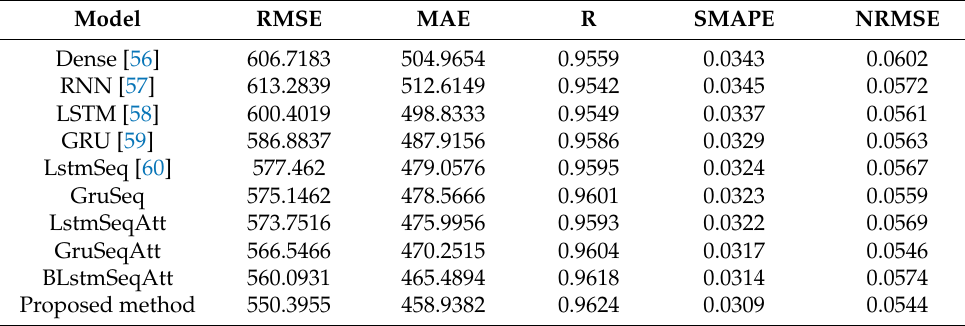
Table 2. Errors of the prediction result in different